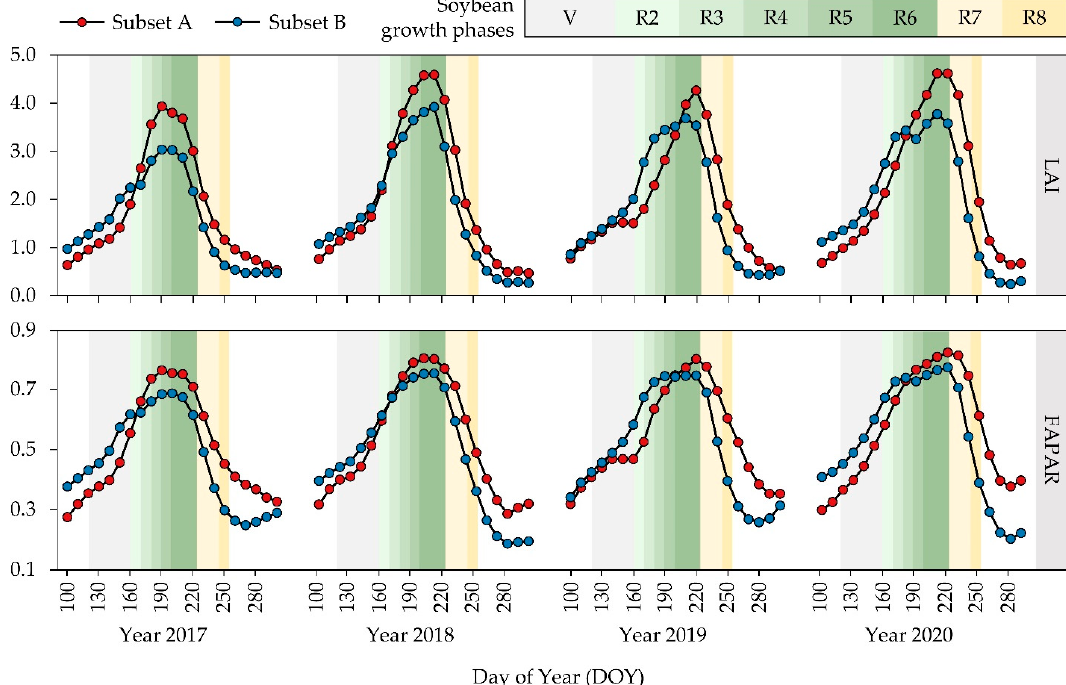
Figure 6. Mean LAI and FAPAR values in the soybean vegetative periods during 2017–2020. The total count and coverage of the soybean samples used for the determination of training and test data for soybean cropland suitability assessment are displayed in Table 4. Both subsets produced a relatively stable sample count for each year within the 2017– 2020 period. Subset B produced a higher sample count and relative coverage in the subset area due to the significantly higher amount of enlarged soybean parcels in lowland areas than Subset A. A relative percentage of sample coverage within the subset agricultural areas is in accordance with the specifications by Colditz [60], who proposed at least 0.25% from the classified area being designated as training data.